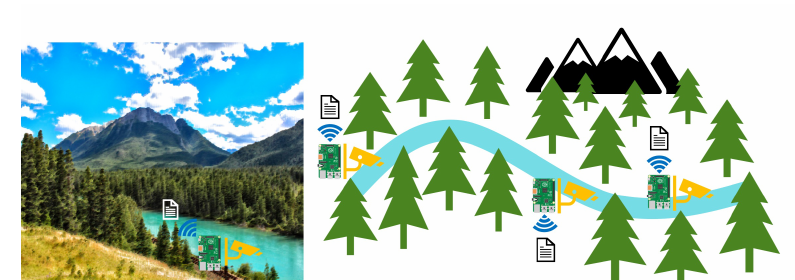
Figure 2. Sketch of a cluster of monitoring devices installed along a river located in a remote place with constrained/limited data